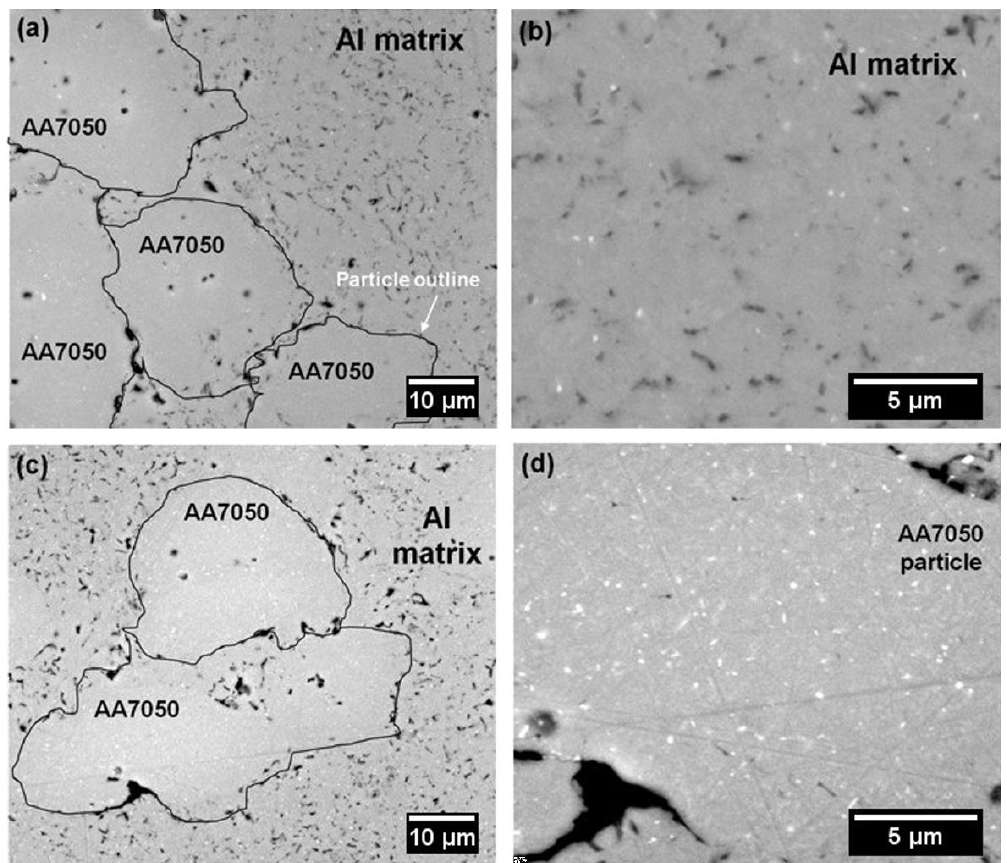
Figure 5. Hot extruded Composite B (a, b) after solubilization treatment images focusing on the precipitates in the Al matrix, and, (c, d) after aging treatment images focusing on the precipitates of AA7050.